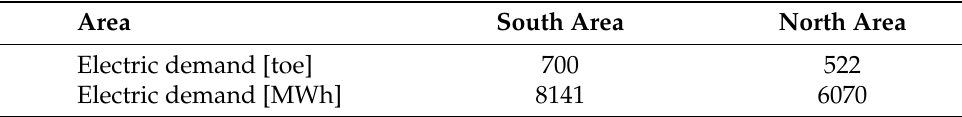
Table 12. Estimated energy demand by area for